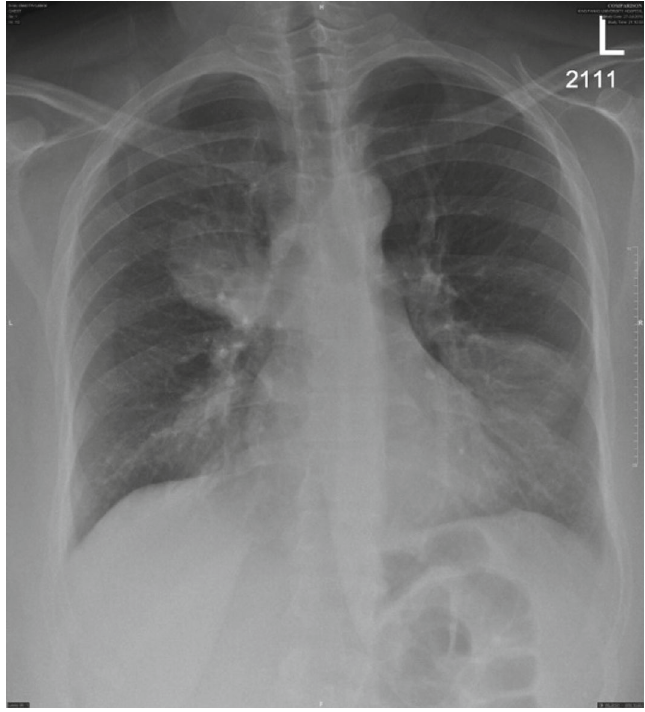
Figure 1: CXR showed bilateral opacities over the right middle and left lower